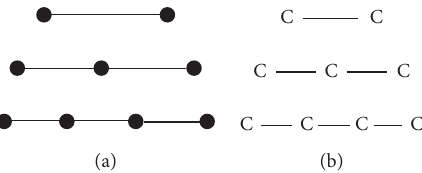
Figure 1: (a) Simple structure of alkanes P